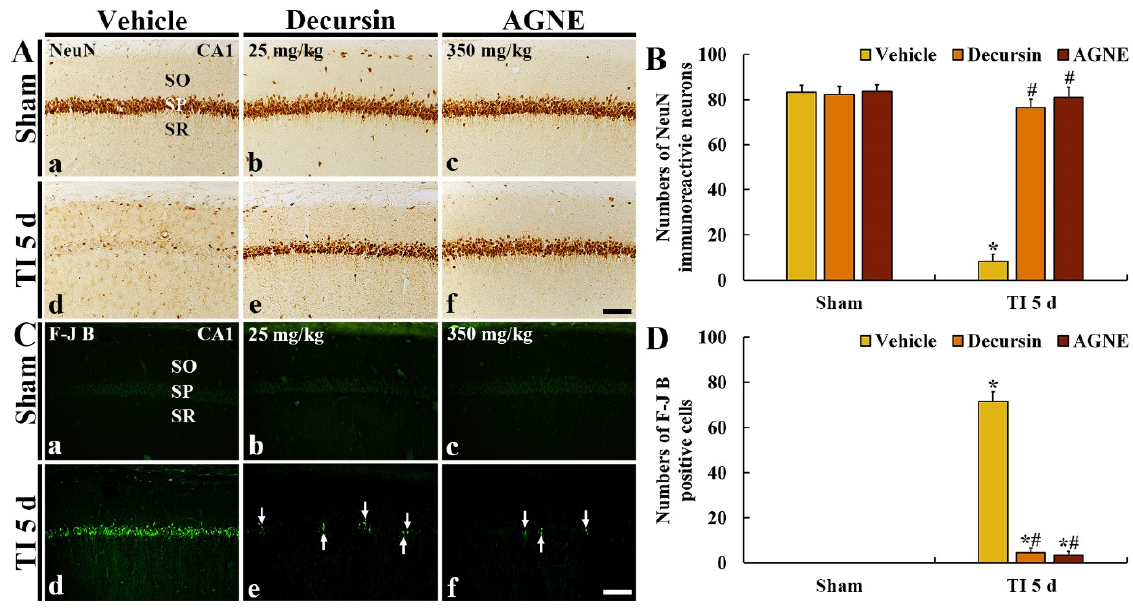
Figure 5. ( A , C ) Immunohistochemistry with NeuN ( A ) and histofluorescence with fluoro-Jade B (F-J B) ( C ) in CA1 of the sham/vehicle, sham/decursin, and sham/AGNE groups ( a – c ), and TI/vehicle, TI/decursin, and TI/AGNE groups ( d – f ) at 5 days after TI. In the TI/vehicle group, NeuN immunoreactive pyramidal neurons are rarely found, whereas many F-J B positive pyramidal neurons are observed in the stratum pyramidale (SP) at 5 days after TI. However, in the TI/decursin and TI/AGNE groups, many NeuN immunoreactive and a few F-J B positive pyramidal neurons (arrows) are observed in the SP. ( B , D ) The mean numbers of NeuN immunoreactive ( B ) and F-J B positive ( D ) pyramidal neurons. SO, stratum oriens; SR, stratum radiatum. Scale bar = 100 μ m. The bars indicate the means ± SEM ( n = 7 per group, * p < 0.05 versus sham/vehicle group, # p < 0.05 versus TI/vehicle group).